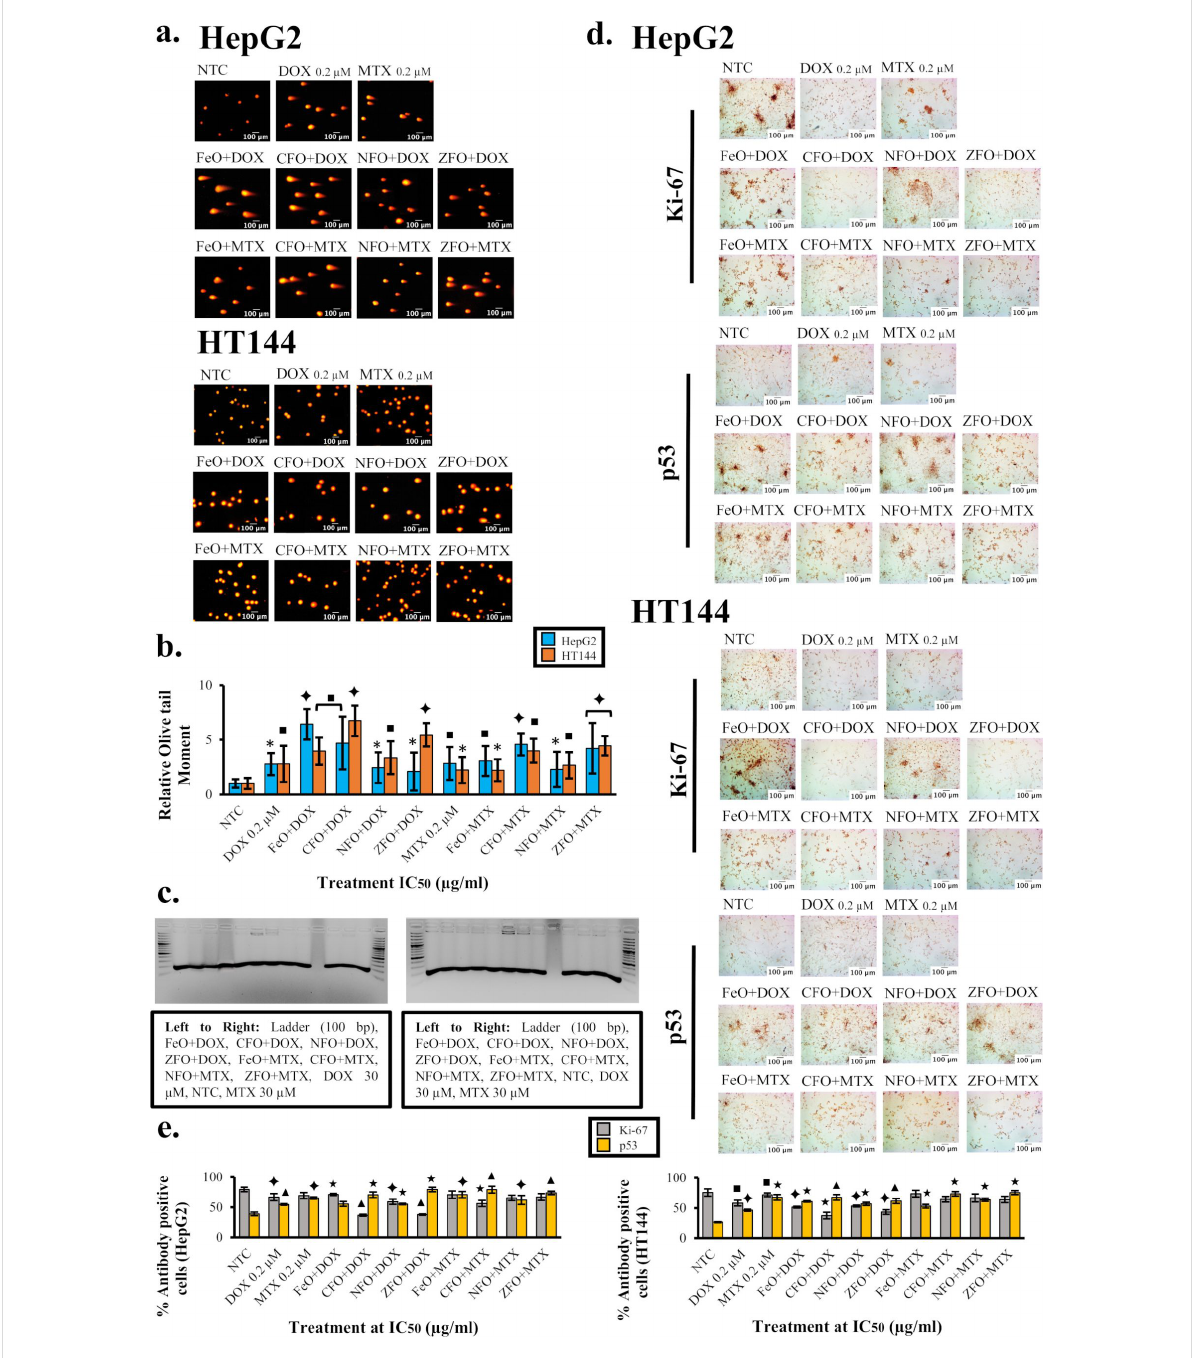
Figure 7: (a) Comet images of HepG2 and HT144 cells treated with drug-loaded (DOX and MTX) MFe 2 O 4 (M = Fe, Co, Ni, Zn) NPs at IC 50 doses for 1 h. Controls included free drugs (DOX and MTX, 0.2 μ M each) and NTC. Cells were stained with propidium iodide (5 µg/mL). Magnification = 200×, scale bar = 100 μ m. (b) Olive tail moment values as a measurement of DNA damage (mean ± SD) were calculated relative to NTC for each sample. p < 0.05 (one asterisk), p < 0.01 (black square symbol), and p < 0.005 (black diamond symbol), paired two-tailed t -test when compared to NTC. (c) From left to right: apoptotic DNA fragmentation in HepG2 and HT144 cells after treatment with NPs+drugs for 24 h at IC 50 doses. Free drugs (DOX and MTX, 30 µM) and NTC were included as controls. DNA samples were electrophoresed on a 2% agarose gel for 2 h at 50 V along with a DNA ladder (100 bp). (d) Microscopy images of immunocytochemical (ICC) staining of treated (IC 50 doses of NPs+drugs for 24 h) HepG2 and HT144 cells with Ki-67 and p53 mouse monoclonal antibodies. Controls included NTC and free drugs (DOX and MTX, 0.2 μ M). Magnification = 200×, scale bar = 100 μ m. (e) Bar charts representing the expression levels of Ki-67 and p53 antibodies in treated HepG2 and HT144 cells. Antibody positive cells were counted in treated and untreated samples and percentages were calculated (mean ± SD). p < 0.01 (black square symbol), p < 0.005 (black diamond symbol), p < 0.001 (black star symbol), and p < 0.0005 (black triangle symbol), paired two-tailed t -test upon comparison with